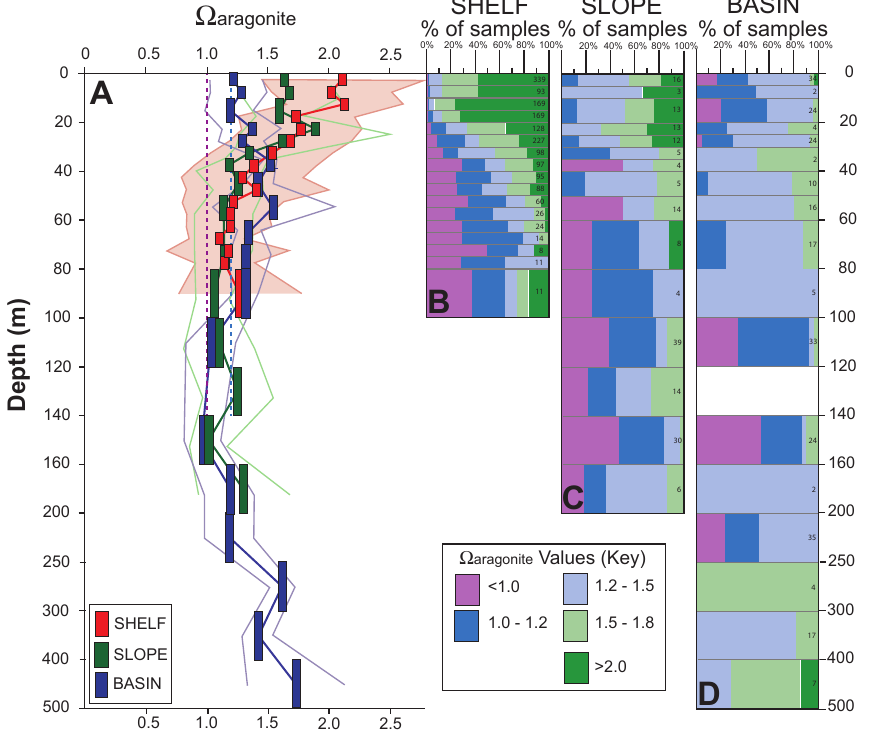
Fig. 6. Composite figure of mean (cid:127) aragonite values for shelf, slope and basin waters from the western Arctic Ocean (includes the Chukchi Sea, eastern East Siberian Sea, western Beaufort Sea shelf and Canada Basin) as observed during the 2009–2011 RUSALCA/ICESCAPE expeditions. The panels include (A) mean (cid:127) aragonite values for shelf (red symbol), slope and basin for different depth intervals. The standard deviation of mean shelf (cid:127) aragonite at each depth interval is shown in light red, and gives some indication of range of (cid:127) values. The standard deviation of (cid:127) values is also shown for slope (green lines) and basin (blue lines) waters. The vertical height of each mean (cid:127) aragonite value shows the depth interval (i.e., 0–5m for uppermost depth interval); (B) the % of sampled water within the defined (cid:127) ranges (i.e., < 1.0 is shown as purple; 1.0–1.2 as deep blue, 1.2–1.5 light blue, 1.5–2.0 as light green, and > 2.0 as dark green); (C) as in panel B but for slope waters; and (D) as in (B) but for basin waters. As in (B) , (cid:127) values in (C) and (D) are differentiated by color (i.e., < 1.0 is shown as purple; 1.0–1.2 as deep blue, 1.2–1.5 light blue, 1.5–2.0 as light green, and > 2.0 as dark green). In (B) , (C) , and (D) , the number of samples (i.e., n of sample within the depth horizon) that comprise each binned depth horizon is given in the right-hand corner of each depth bin, replicating n values given in Table 1.